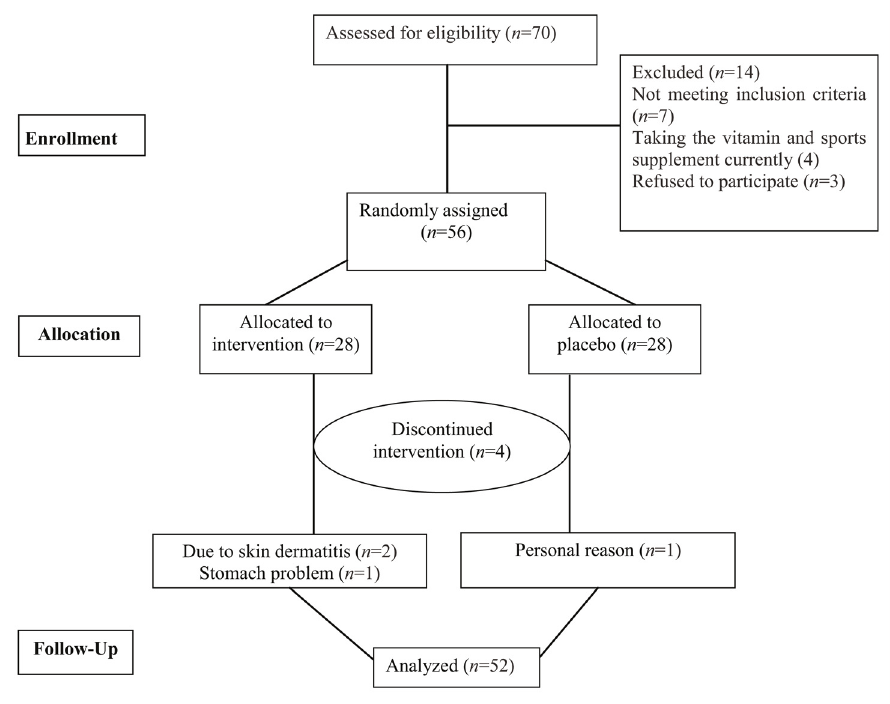
Figure 1. Schematic diagram of the study; Individuals in the L-arginine group received capsule containing 2000 mg of L-arginine per day during the study; those in the placebo group received 2000 mg placebo capsule at the same